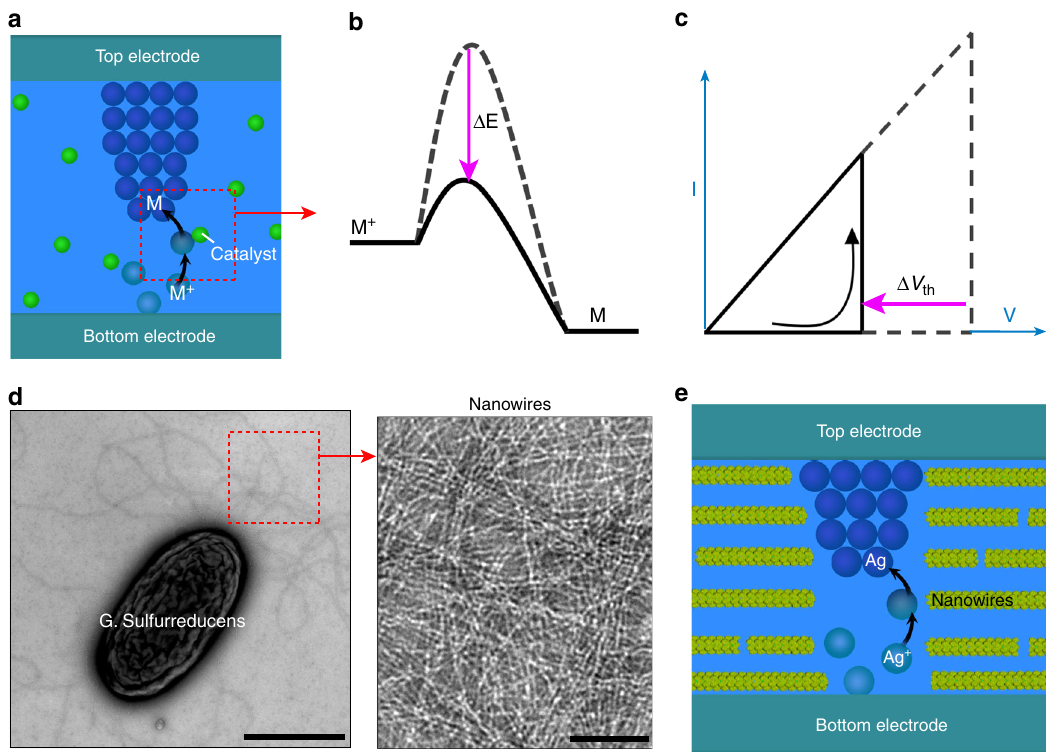
Fig. 1 Proposal of catalyzing bio-voltage memristors. a Schematic of an introduced catalyst (green dot) in a memristor that facilitates the cathodic reduction by ( b ) bringing down the reduction overpotential ( Δ E ), which leads to ( c ) a decrease in the switching voltage ( Δ V th ). d TEM images of a G. sulfurreducens and puri fi ed protein nanowires (right) harvested from G. sulfurreducens. Scale bars, 1 µ m (left) and 100 nm (right). e Schematic of introduced protein nanowires in a memristor that facilitate the cathodic reduction of Ag + to attain possible bio-voltage